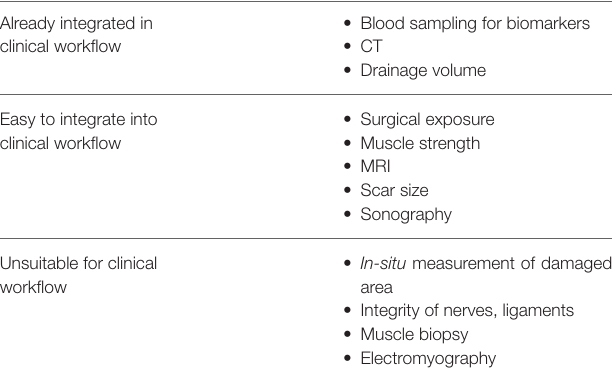
TABLE 4 | Integrability of the surgical approach assessment